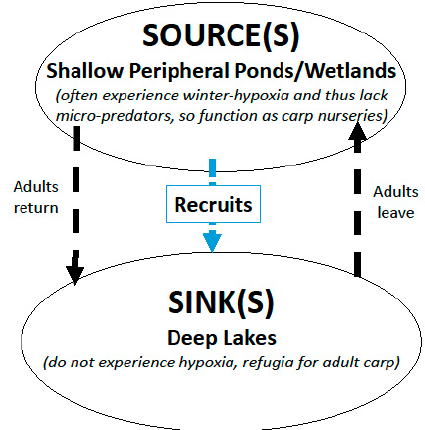
Figure1. Schematicofthesource-sinkprocesshypothesizedtodeterminetheabundanceofcommoncarp inmanyMidwesternchainsoflakes.Thedashedarrowsshowthatmost, butnotall, adultsmovebetween deep lakes and peripheral shallow water bodies to spawn and then return to lakes after the spawning season. Some adults may also occasionally overwinter in shallow waterbodies. Being long-lived, this flexible movement strategy, also known as partial migration, seems to work to the carp’s advantage, especially in dynamic and complex temperate ecosystems that experience occasional flooding and